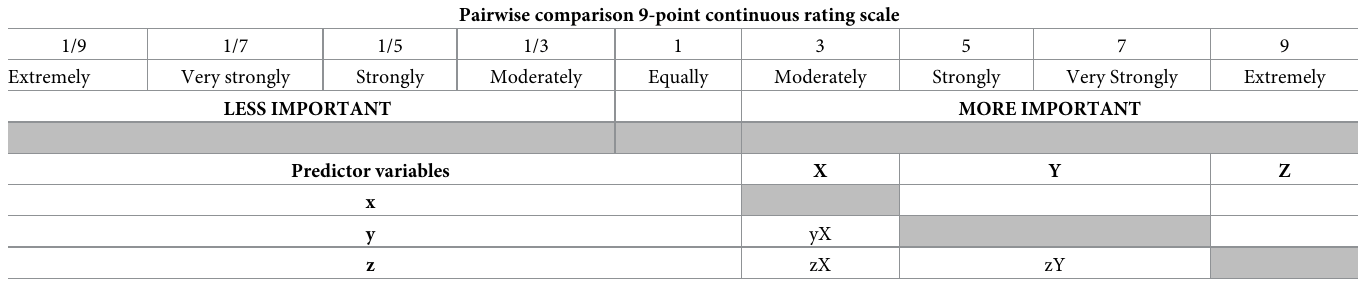
Table 5. Rating scale used for pairwise comparisons between predictor variables.